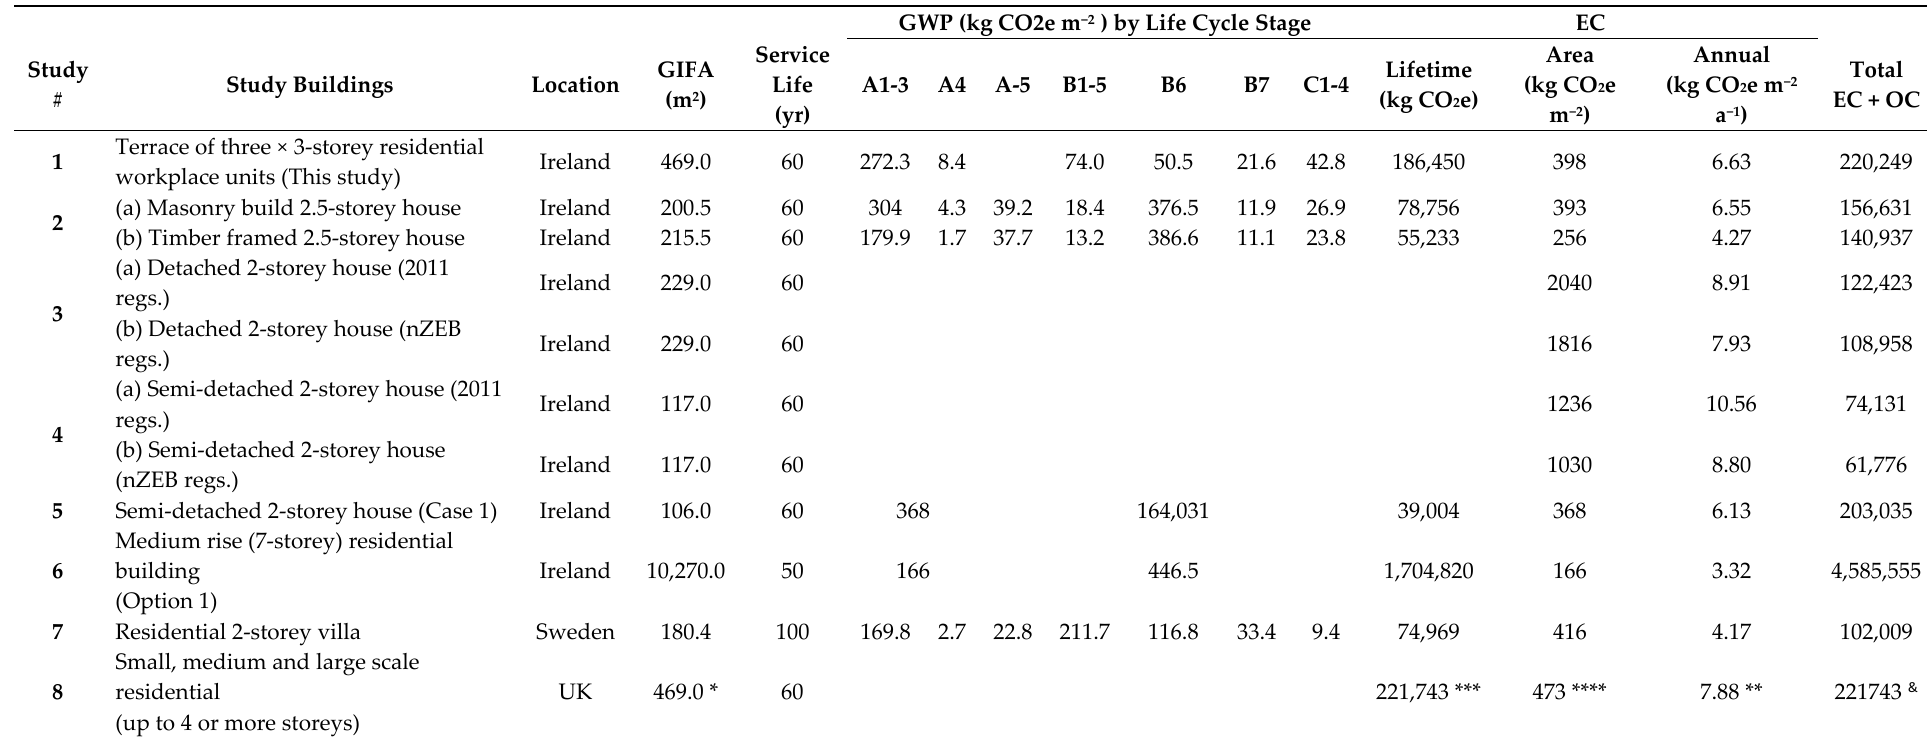
Table 3. Global warming potential (GWP) and embodied carbon (EC) comparison for European residential buildings.